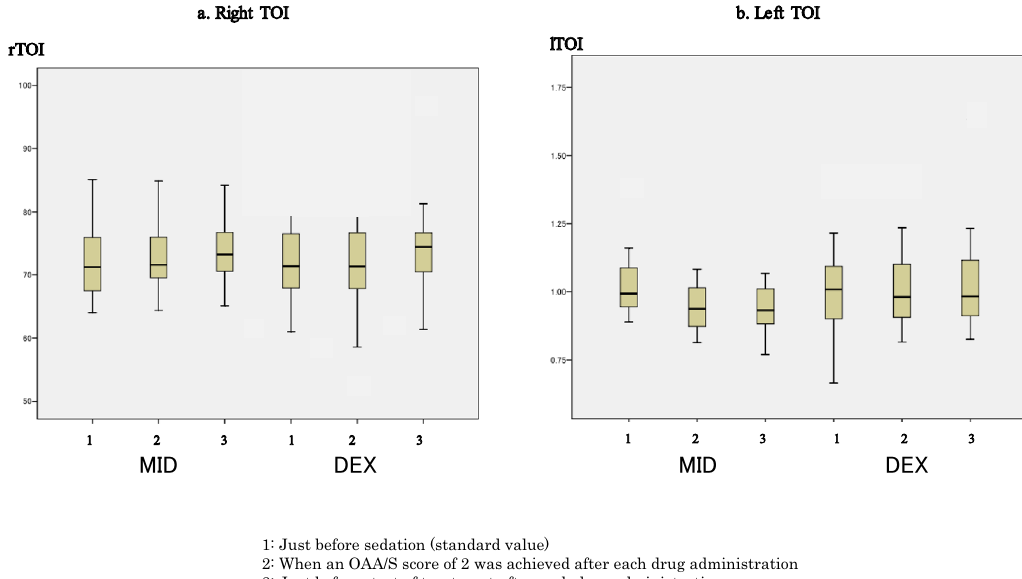
Figure 6. Changes in tissue oxygenation index (TOI). ( a ) Right TOI values were 71.3 (66.9–76.6)% just before sedation (baseline value), 71.6 (69.5–76.9)% when a Modified Observer’s Assessment of Alertness/Sedation (OAA/S) score of 2 was achieved after midazolam administration, and 73.3 (70.4–76.9)% just before start of treatment in the midazolam group; and 71.4 (67.5–78.6)% just before sedation (baseline value), 71.4 (67.4– 79.2)% when an OAA/S score of 2 was achieved after dexmedetomidine administration, and 74.5 (70.2–77)% just before start of treatment in the dexmedetomidine group. ( b ) Left TOI values were 72.1 (70–76.7)% just before sedation (baseline value), 74.2 (70.6–76.4)%when an OAA/S score of 2 was achieved after midazolam administration, and 76.4 (73.6–79.8)% just before start of treatment in the midazolam group; and 75.3 (70.4– 82.3)% just before sedation (baseline value), 74.7 (70.3–83.1)% when an OAA/S score of 2 was achieved after dexmedetomidine administration, and 77.8 (73.7–82.9)% just before start of treatment in the dexmedetomidine group. There were no significant differences in TOI values at each time point (measurement points 1, 2 and 3) between the midazolam and dexmedetomidine groups. Comparison of data at each time point (measurement points 1, 2 and 3) in each group indicated no